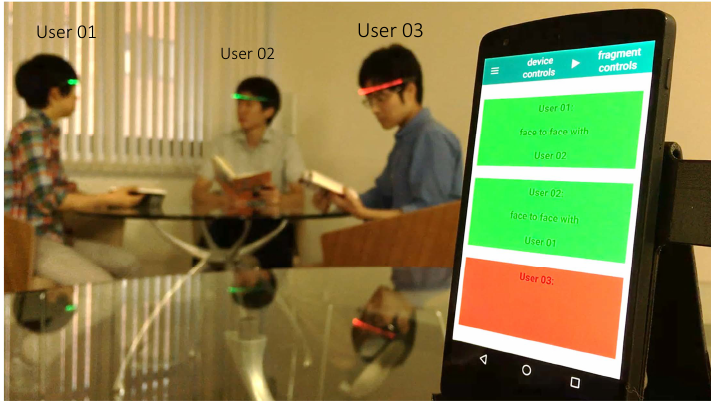
Figure 2. Cooperating with an Android device allows monitoring and automatic logging of face-to-face